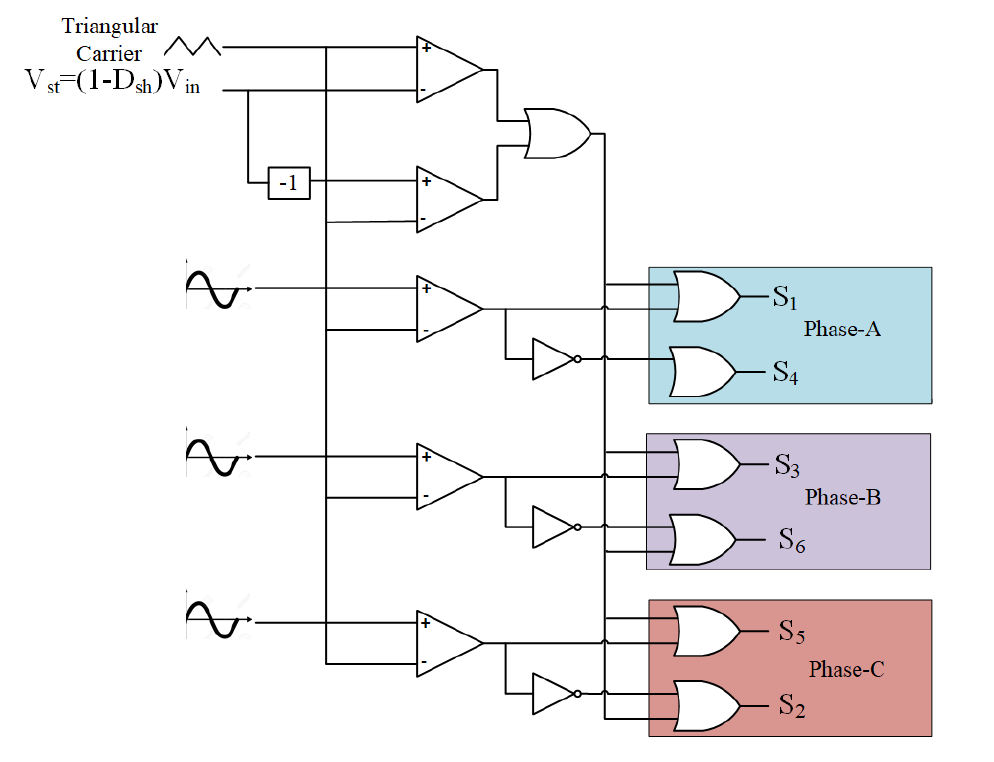
Figure 2. Proposed modulation